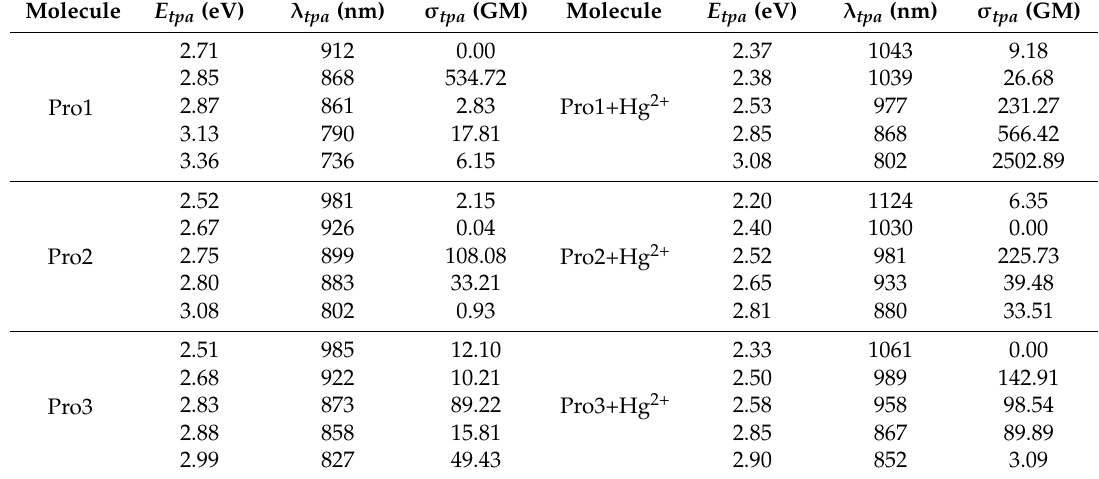
Table 2. TPA properties, including the excitation energy E tpa (eV), the corresponding